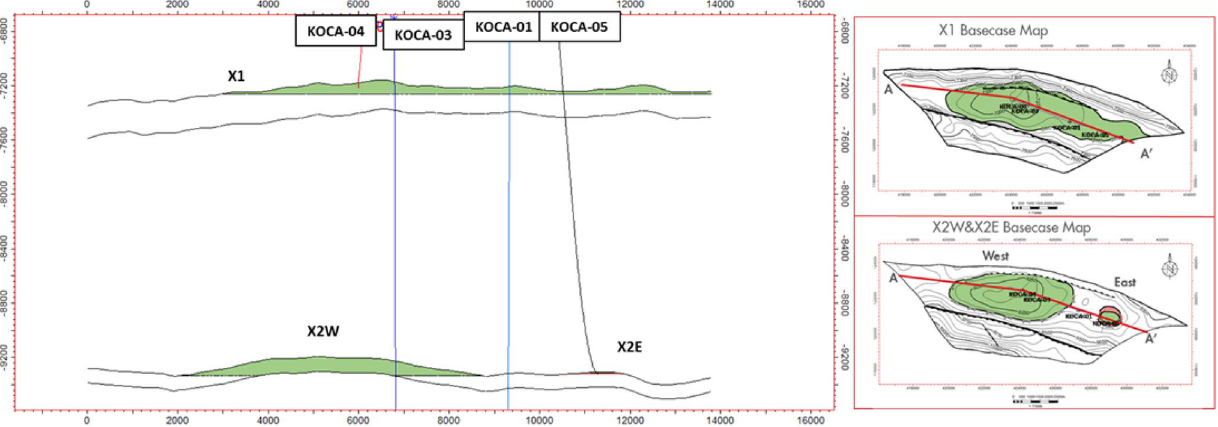
Fig. 5 Top structure map for X1 and X2 reservoirs with cross section along strike